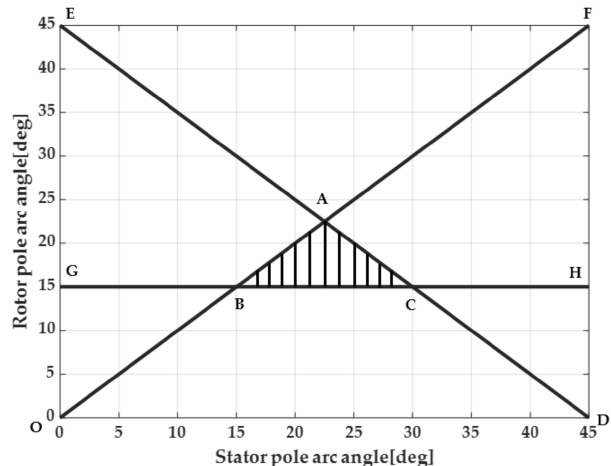
Figure 3. Feasible pole arc angle.